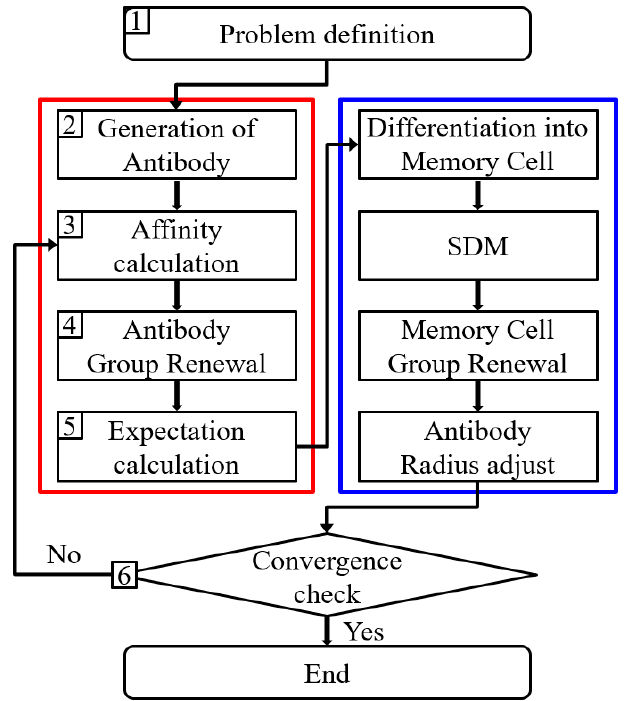
Figure 5. Flow chart of the Novel Immune Algorithm.